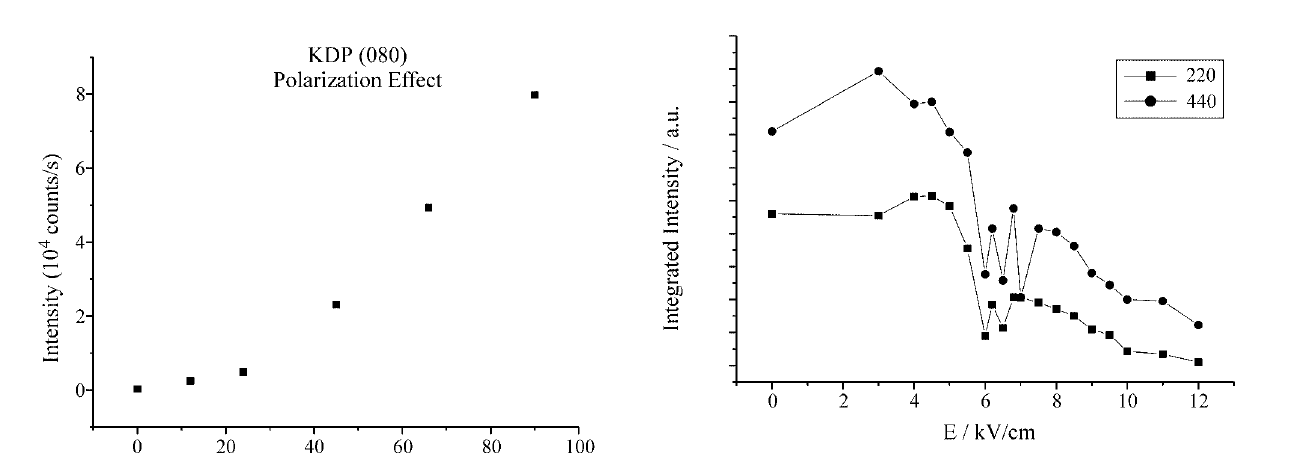
Figure 3. KDP integrated intensity of(220) and (440)as a function ofthe electric field(E[001])showingtheinducedphasetransitionatE=6kV/cm for T = 28